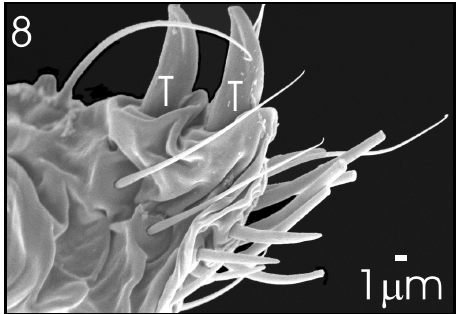
Fig. 8. The apex of the distal tip of the male antenna showed two teeth (T) which are used during copula- tion.